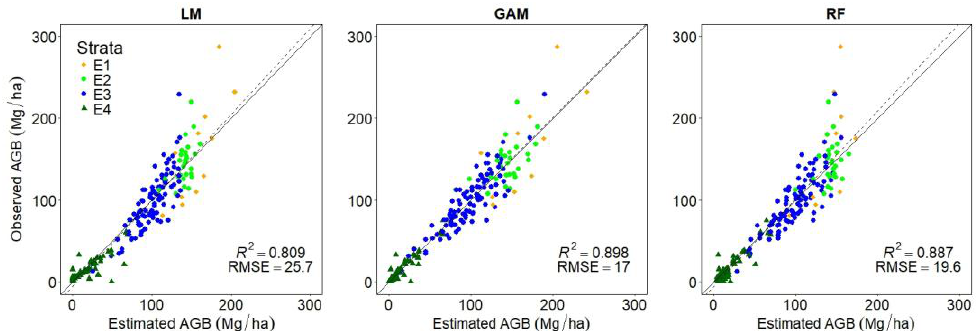
Figure 6. Observed versus model predictions data for plot-level AGB resulting from models of LM (Linear Model), GAM (Generalized Additive Model), and RF (Random Forest) for the managed forests in the Zacualtipán forested region. Solid lines represent the 1:1 line and dotted lines represent the slope. R 2 and RMSE values were derived from 10-fold cross-validation as the measure of the model performances. Strata represent the age class of the forest stand (E1 = 80 years, E2 = 25–31 years, E3 = 14–22 years, E4 = 0–13 years).